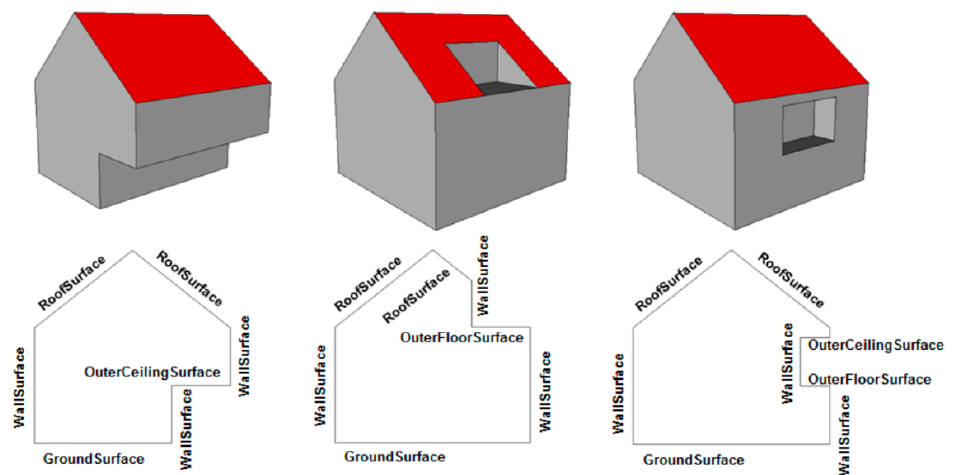
Figure 12. Building surface types defined by CityGML [19].